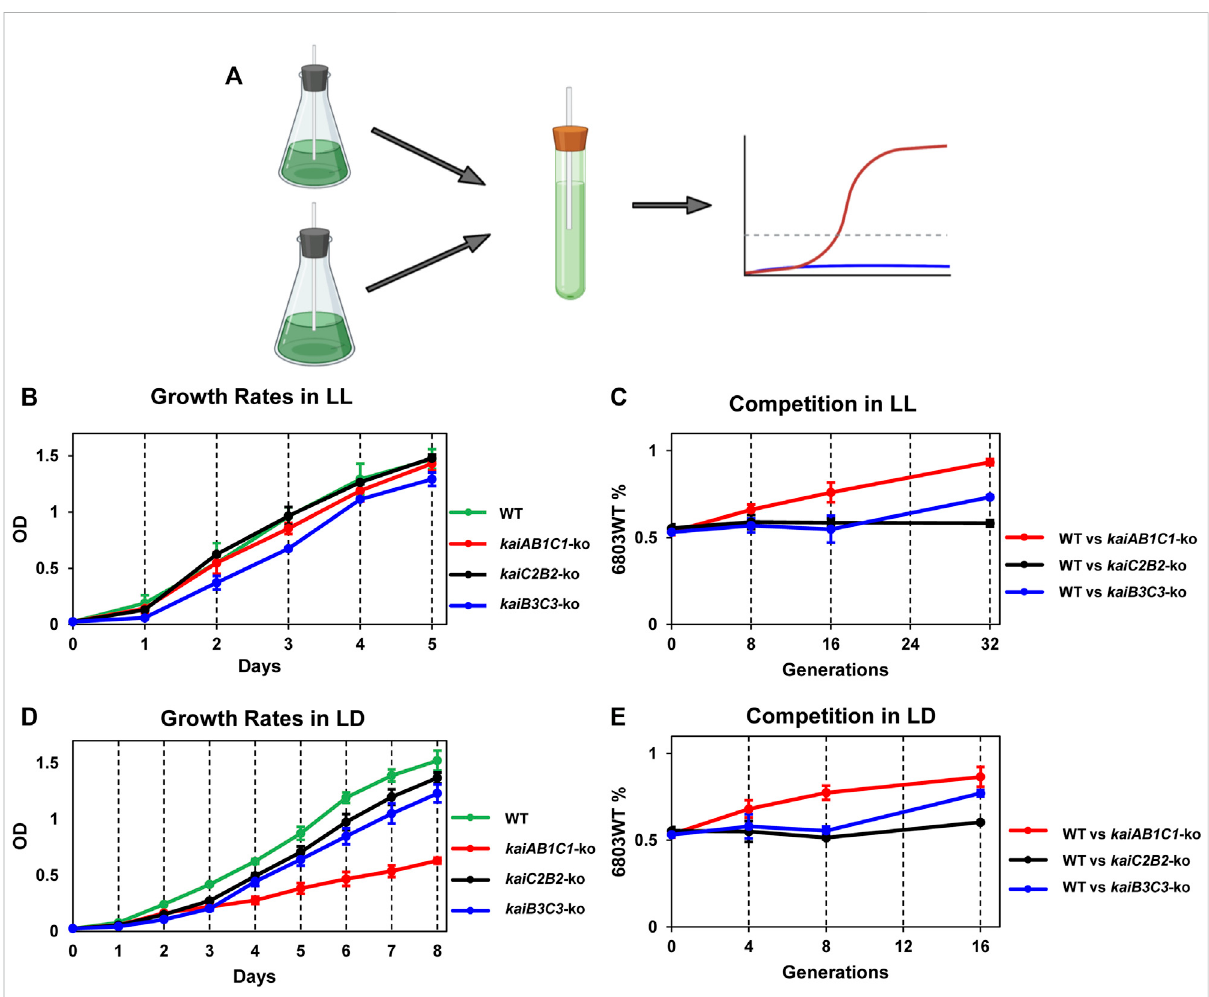
FIGURE 6 Adaptive fi tness of the various kai gene clusters assessed by growth rates of monocultures and competition assays. The Synechocystis strains that were tested include wild-type (WT) and knockouts of the three different kai gene clusters ( kaiAB1C1-ko, kaiC2B2-ko and kaiB3/kaiC3-ko ). (A) . Mixed-strain cultures were grown in competition and changes in population structure quanti fi ed by QPCR of strain-speci fi c sequences. (B) . Growth curvesofthefourstrainsinLLasassessedbylightscatteringofthecellculture(measuredatOD 730 )asafunctionoftime. (C) .CompetitionofWT againstthe kaiAB1C1-ko,kaiC2B2-ko or kaiB3C3-ko strainsovergenerations/timeinLL.TheordinateplotsthepercentageoftheWTstrainovertime under competition. (D) . Growth curves of the four strains in LD 12:12 as assessed by light scattering of the cell culture (measured at OD 730 ) as a functionoftime. (E) .Competition ofWT against the kaiAB1C1-ko,kaiC2B2-ko or kaiB3C3-ko strainsovergenerations/timeinLD12:12. Theordinate plots the percentage of the WT strain over time under competition. Data are plotted as means ± S.D. from three biological